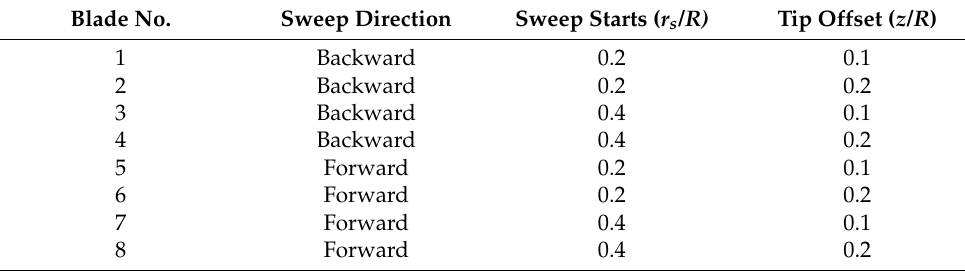
Figure 1. The schematic of the blade sweep.